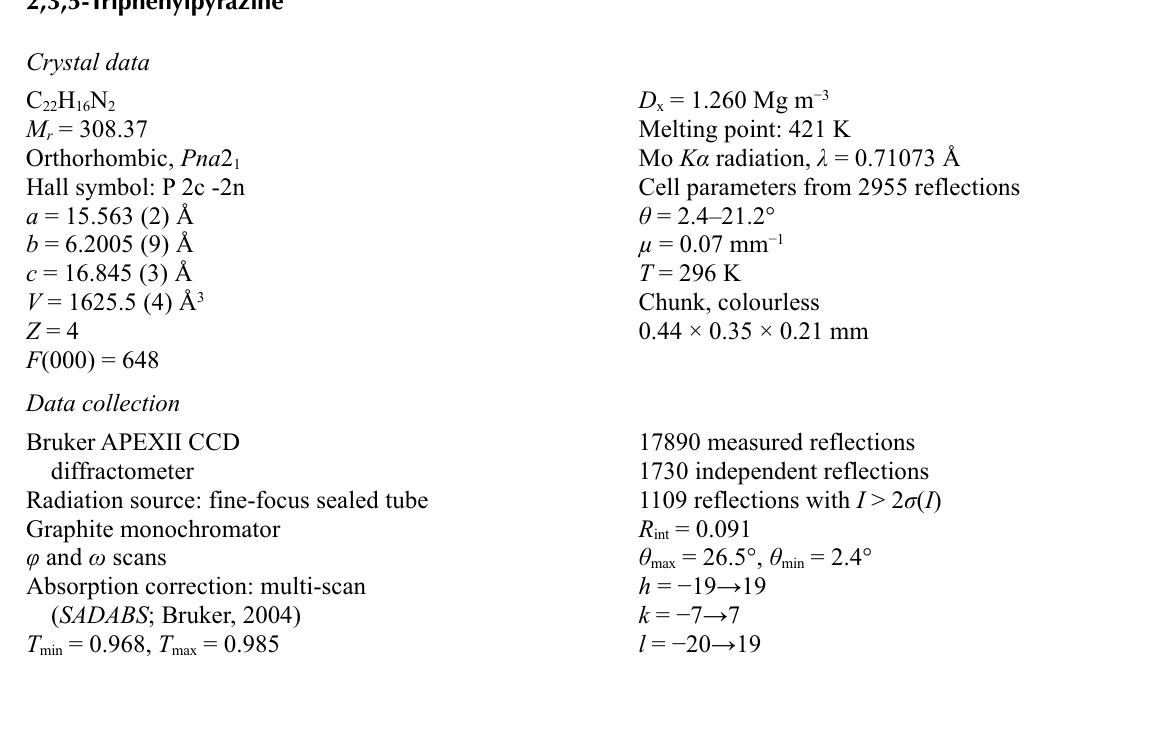
The molecular structure of the title compound, showing the atom-numbering scheme and displacement ellipsoids drawn at the 50% probability level. H atoms are shown as small spheres of arbitrary